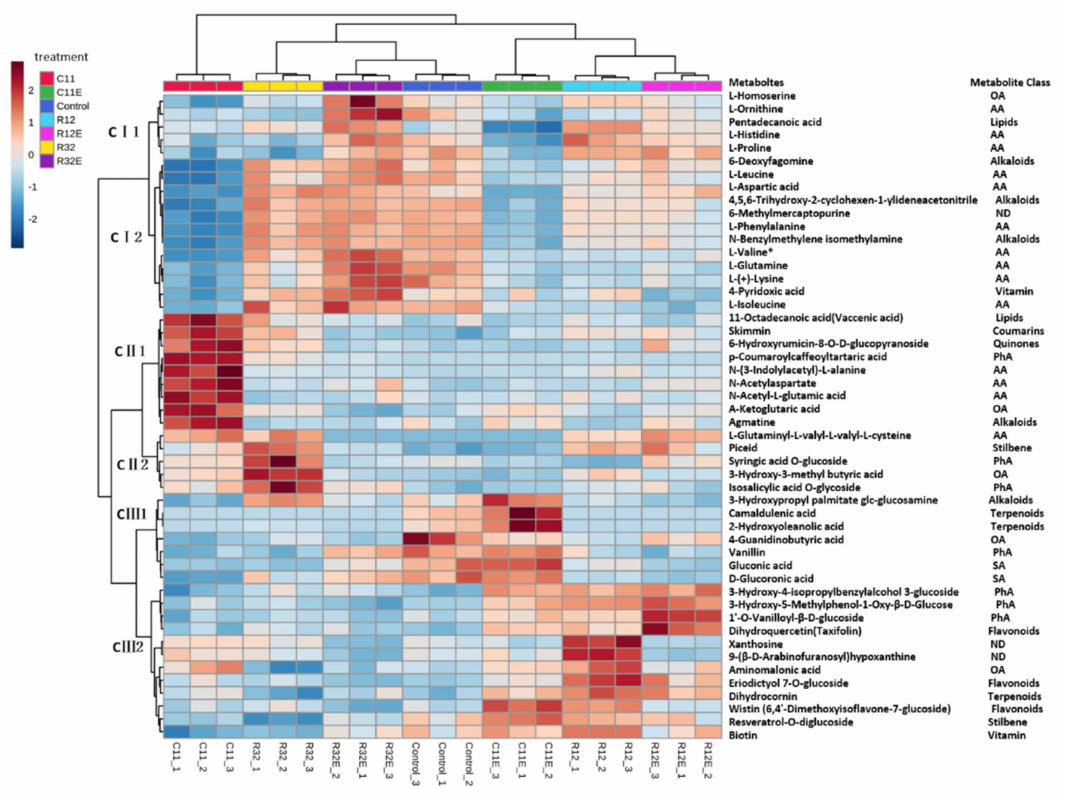
Figure 2. Heatmap and hierarchical cluster of the 50 most influenced metabolites in fungi- and fungal extract-exposed grape cells. C11, R12, R32, C11E, R12E, R32E, and control briefly represent the samples treated with the corresponding endophytic fungal strains or their derived fungal extracts or no treatment as control. The abbreviated metabolite classes are: OA: organic acids; AA: amino acids and derivatives; ND: nucleotides and derivatives; PhA: phenolic acids; and SA: saccharides and